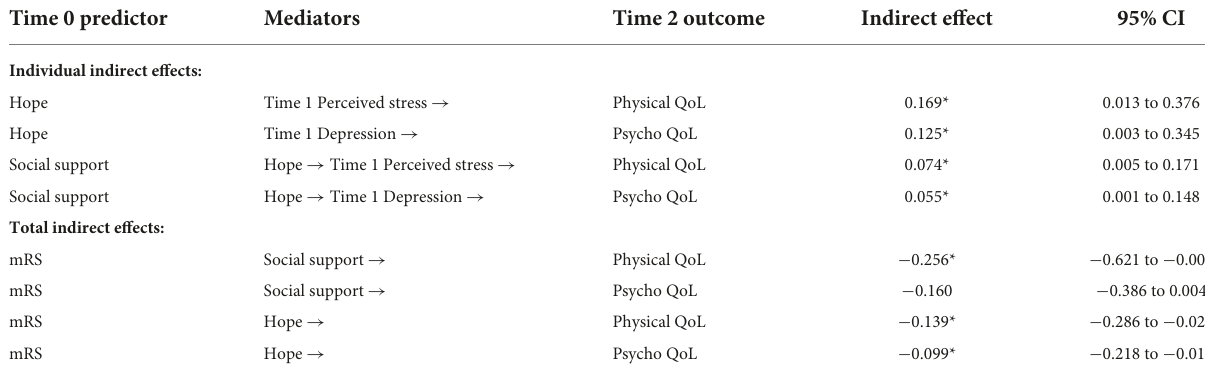
TABLE 3 Indirect effects from hope, social support, and mRS to QoL via perceived stress and